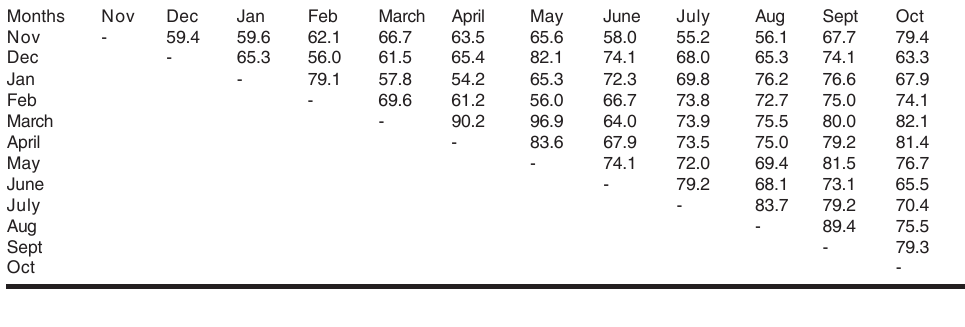
Figure 4. Abundance of Copepoda, Cladocera and microcrustacea